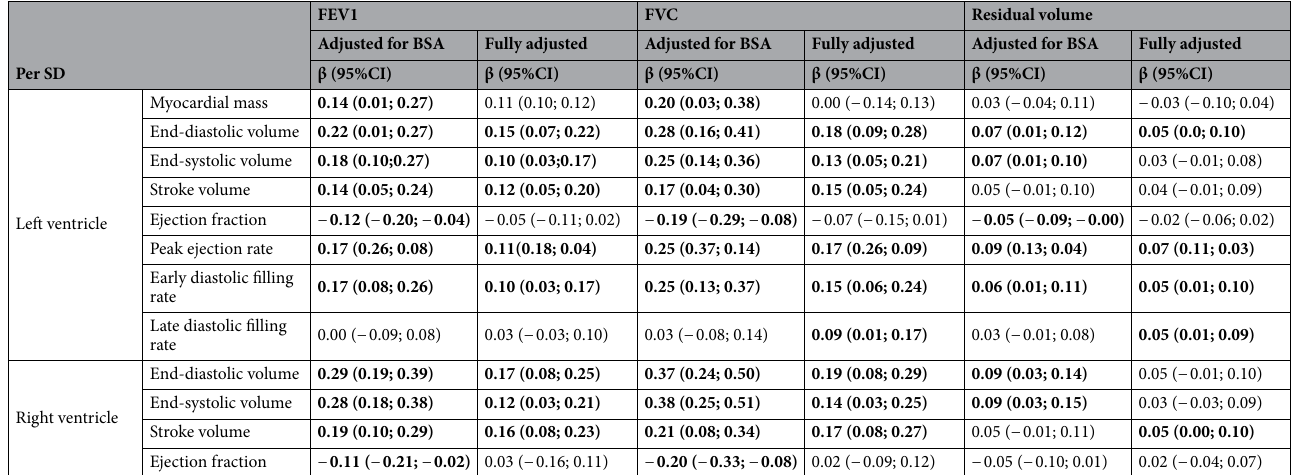
Table 2. Associations between cardiac MR measurements and pulmonary function. The beta estimate given with a 95% confidence interval represents the association size between cardiac measurements and pulmonary function tests. The fully adjusted model includes the following covariates: age, sex, BSA, and smoking status. BSA Body Surface Area, CI 95% confidence interval, FEV1 forced expiratory volume in the first second, FVC forced vital capacity, SD standard deviation. Bold font indicates statistical significance (P < 0.05).